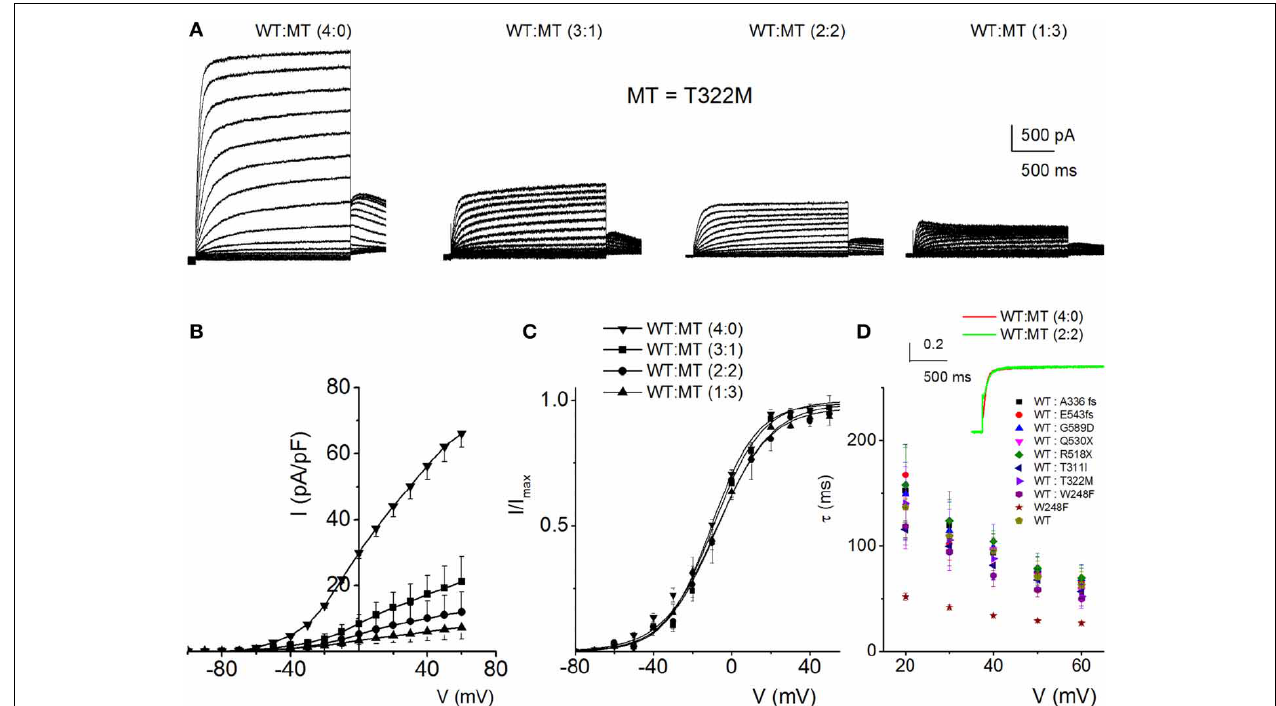
FIGURE 3 | Properties of heteromeric hKv7.1 and JLNS mutant channel currents. (A) Macroscopic outward currents were recorded after expressing homomeric wildtype (WT:MT (4:0) channel, left panel) and upon co-expressing heteromeric hKv7.1 (WT) and MT T322M at different ratios (WT:MT) of 3:1 (left middle panel), 2:2 (right middle panel), and 1:3 (right panel). Representative current traces for a family of K + currents obtained from a holding potential of − 80mV and stepped from − 100 to 50mV using (cid:3) V = 10mV are shown. The tail currents were elicited at − 40mV. (B) Plots of current density-voltage relation of currents derived from WT hKv7.1 alone ( (cid:2) ) and a combination of WT Kv7.1